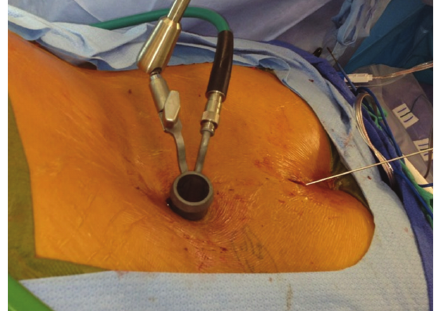
Figure 2: Intraoperative picture showing the METRx tube directed at the pars defect (left side of picture, which is towards the patient’s head) and the guidewire for the screw (right side of the picture). In this case, a single midline cephalad incision was used to access both pars defects with the METRx tube, and a single midline caudal incision used the pass the guidewires and screws. Alternatively, two paired para-sagittal incisions can be used to access each pars defect and a single incision used to pass the guide wires and screws.